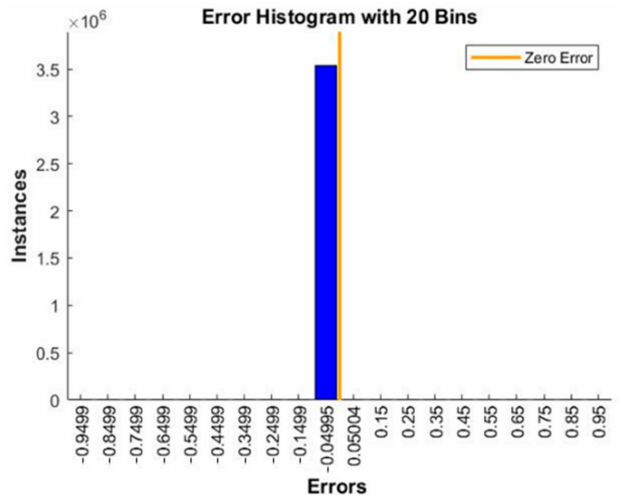
Figure 19. Error